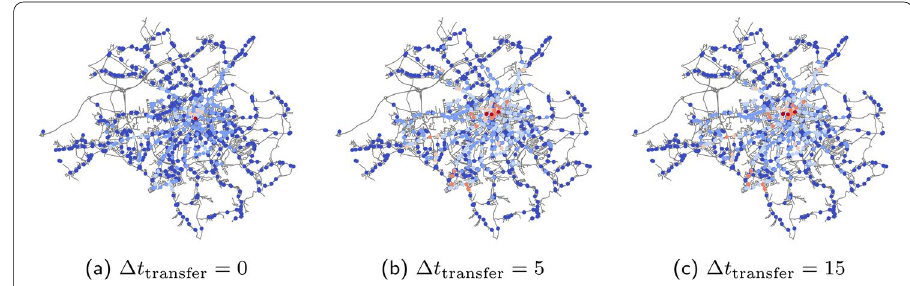
Fig. 11 Marginal node total communicability plots of Chemnitz with varying transfer time (cid:31) t transfer . Central stops are marked red and non-central stops are marked blue. The entries in the supra-adjacency matrix are weighted with travel times and frequencies. The remaining hyper-parameters are chosen as β = 0.5 / (cid:31) max and σ = 1 . The street network in the background of the plots is created with the OSMnx python package (Boeing